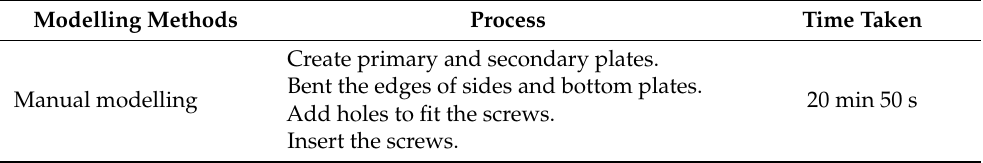
Table 1. The process involved in manual and parametric based modelling of the bracket. Modelling Methods Process Time Taken Create primary and secondary plates. Bent the edges of sides and bottom plates. Manual modelling Add holes to fit the screws. Insert the